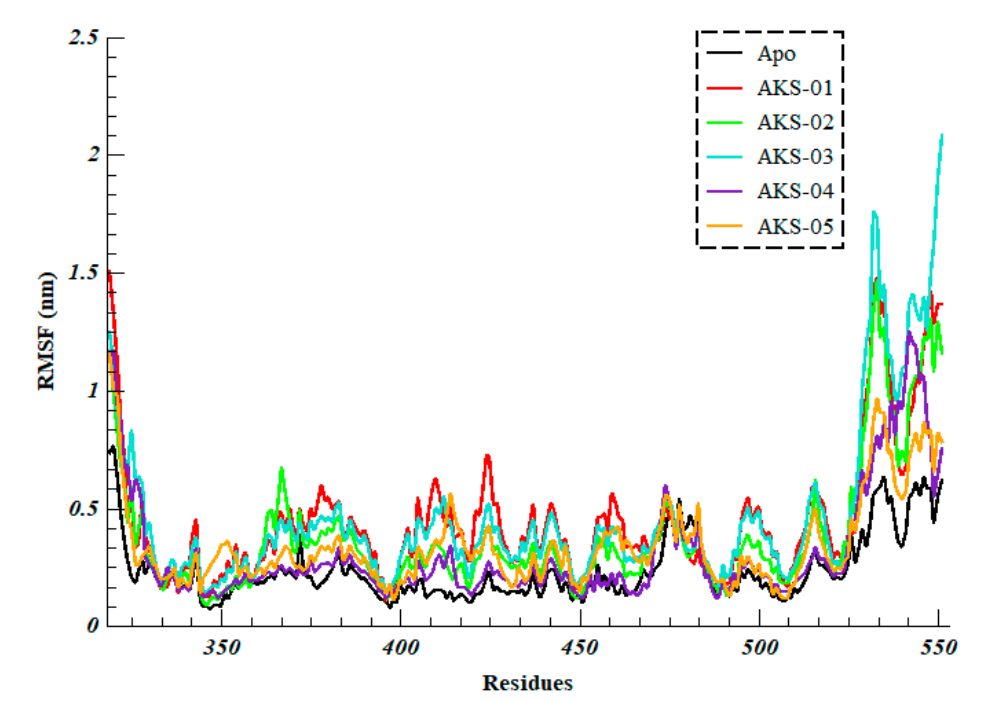
Figure 5. Root Mean Square Deviation of backbone carbon atoms of Apo (Omicron’s RBD) and five selected compounds in complex with RBD over the 100 ns of simulation time.